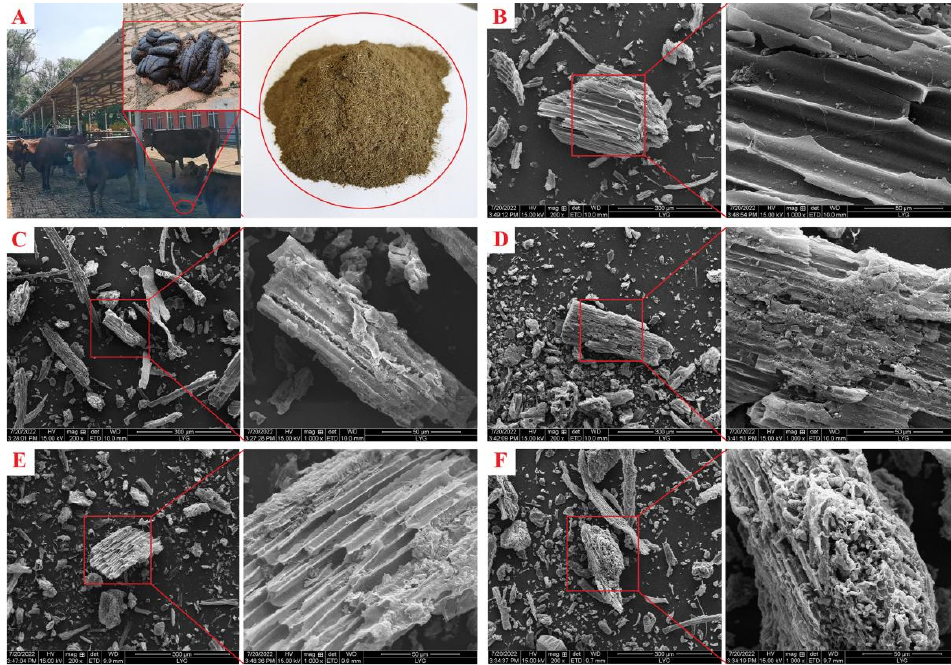
Figure 1. Digital photo of ( A ) CD. SEM images of ( B ) CD, ( C ) CDC, ( D ) BMCD-K, ( E ) BMCD-Na, and ( F ) BMCD-MB.